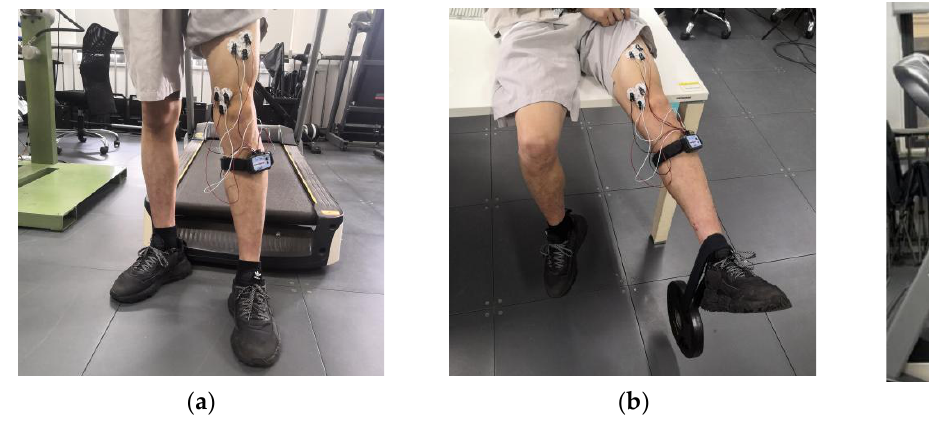
Figure 3. ( a ) The electrode position for the target muscles and the actual situation of wearing and using the instrument; ( b ) the setup for measuring sEMG signals when loading and stretching the knee; and ( c ) the running experimental procedure.